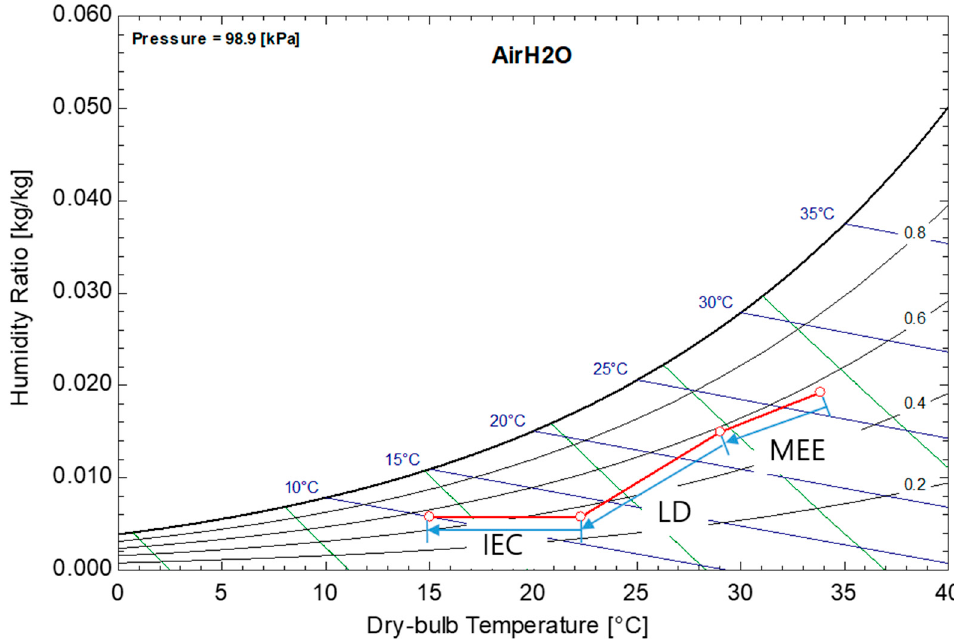
Figure 4. Liquid desiccant and dew-point evaporative-cooler-assisted 100% outdoor air system (LDEOAS).